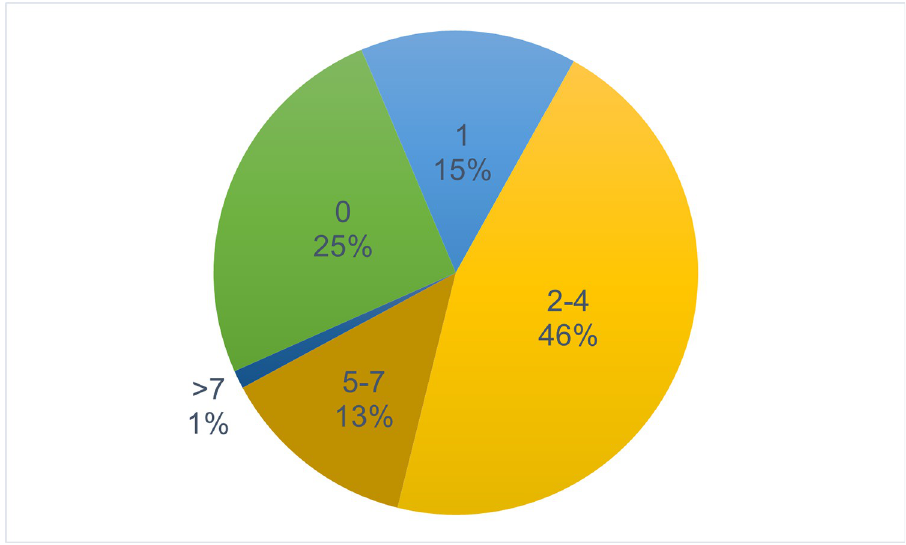
Fig 5. Number of financial dependents reported by AMD students (2017). This pie chart indicates the number of financial dependents reported by AMD students in 2017. Number of financial dependents ranged from 0 to more